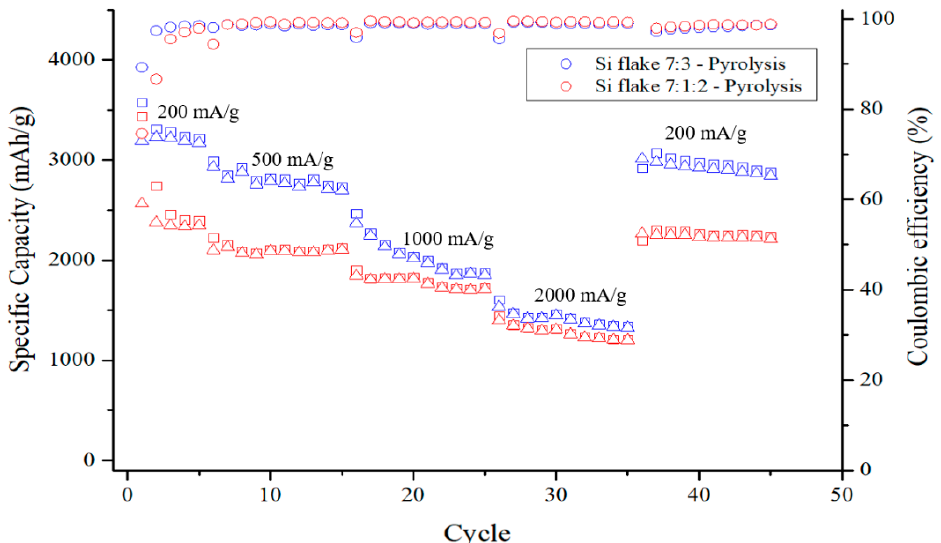
Figure 13. Cycling performance of an anode made of pyrolytic silicon anodes with (1) silicon flake– binder = 70%:30% in weight ratio and (2) silicon flake–KB–binder = 70%:10%:20% in weight ratio at discharge–charge rates varied from 0.2A/g (0.05 C) to 2A/g (0.48 C). The discharge–charge rate is based on the weight of silicon flakes.